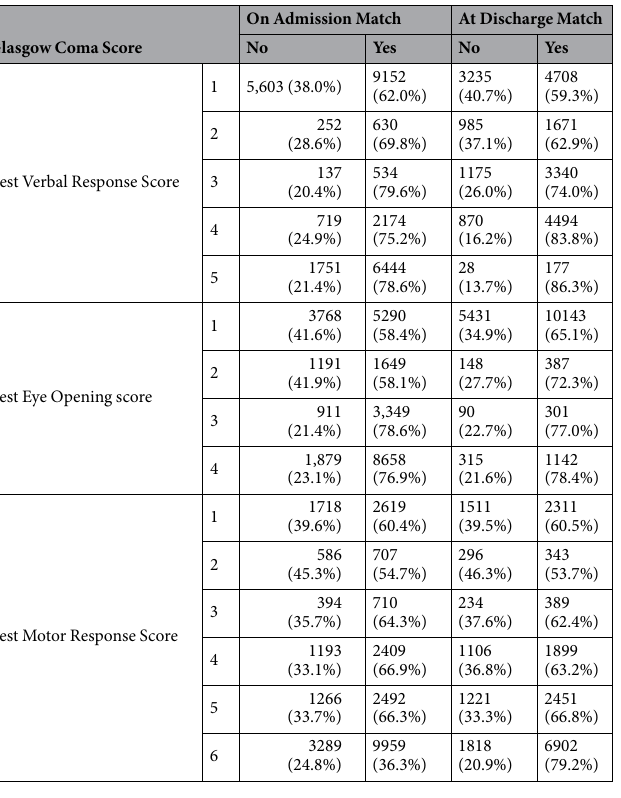
Table 2. Distribution of Matched * observations by Glasgow Coma Scores on admission and at discharge. * Match indicates that for any given observation, NPi ≥ 3 and CV ≥ 0.8 or NPi < 3 and CV <